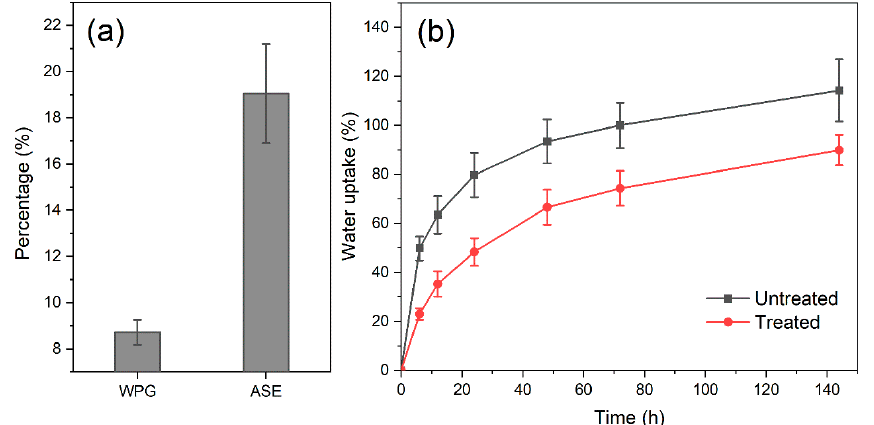
Figure 7. ( a ) Weight percent gain (WPG) and anti-swelling efficiency (ASE) of the treated wood sample, ( b ) water uptake of untreated and treated wood sample as a function of time. The ASE of treated wood sample reached 19% at WPG of 8.7%.